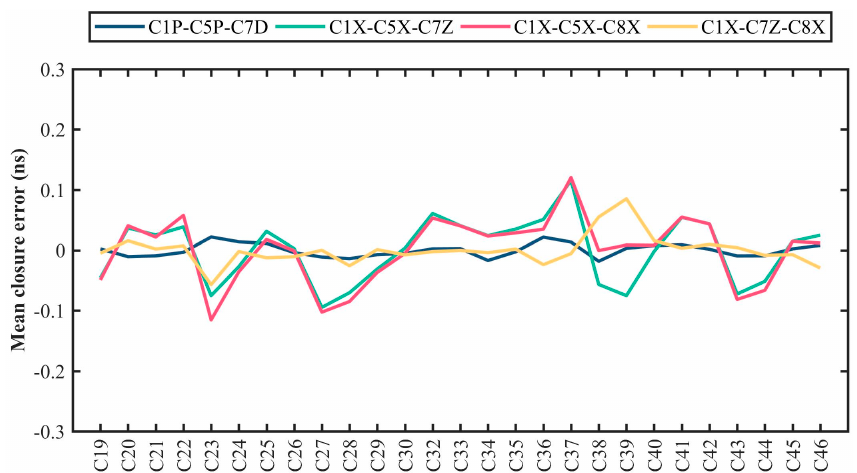
Figure 7. Distribution of BDS-3 satellites C1P-C5P-C7D ( a ), C1X-C5X-C7Z ( b ), C1X-C5X-C8X ( c ), and C1X-C7Z-C8X ( d ) closure errors. The red line denotes the fitted normal distribution curve.